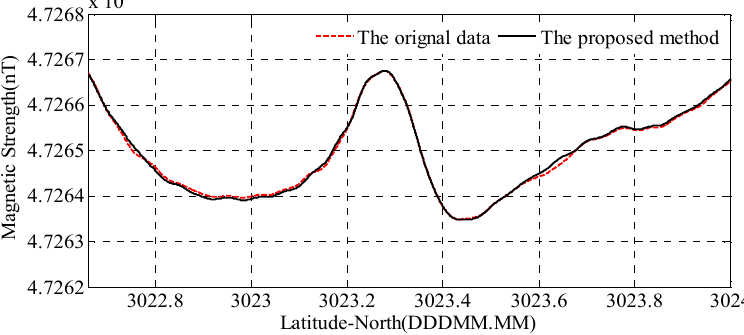
Figure 13. The magnetic field of the flight survey line-2.